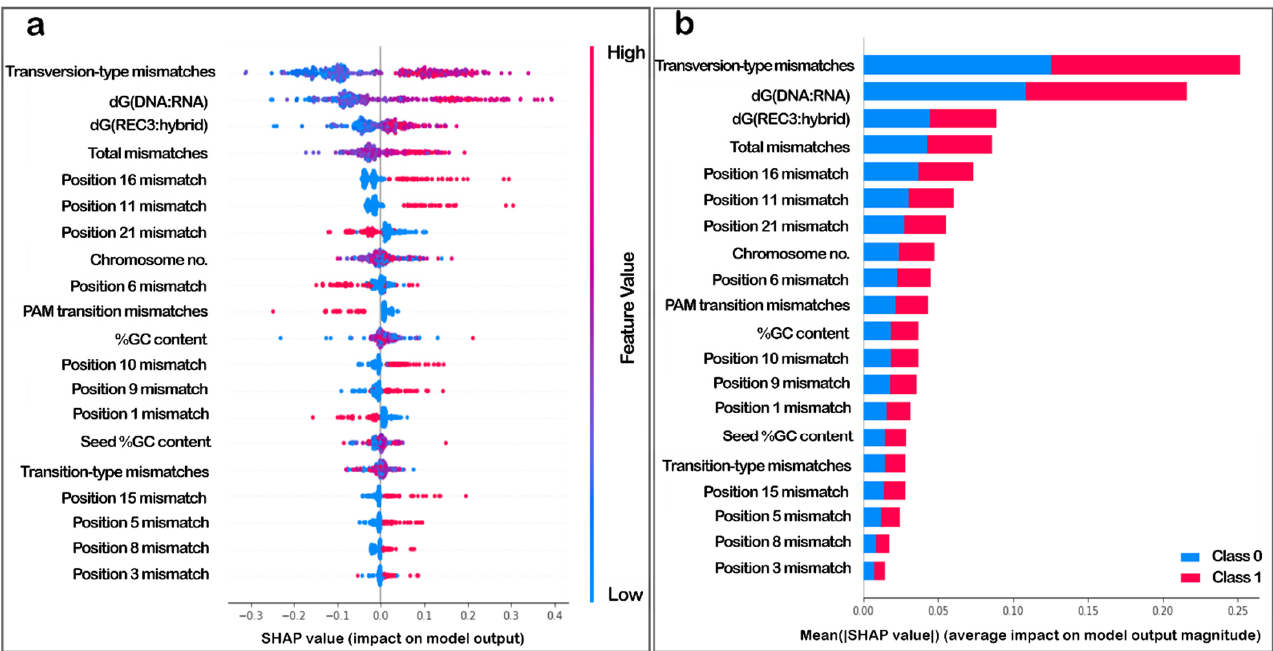
Figure 6. ( a ) SHAP value plot indicating global impact n model output. Each dot is an instance for a datapoint, the colour represents if the value for that instance is low (blue) or high (red). The spread indicates the magnitude of impact on the model output. ( b ) SHAP summary plot shows the impact of the features on each model output, negative class shown in blue and positive class shown in red, as stacked bars, in decreasing order of impact on output.